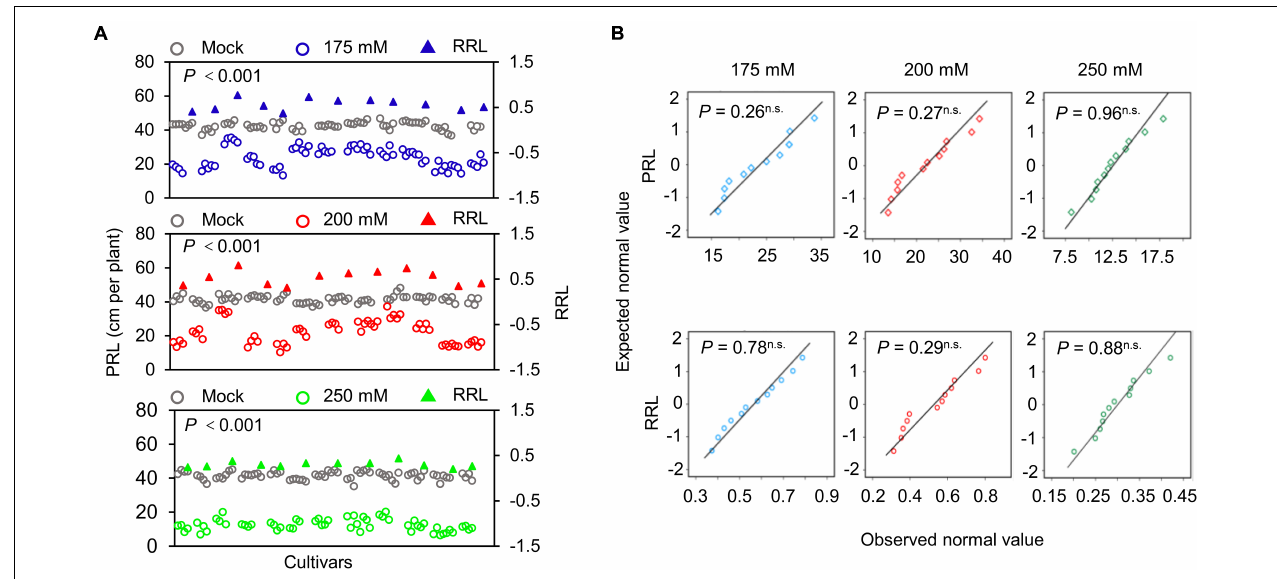
FIGURE 5 | Determination of primary root length. (A) Scatter distribution map of PRL (circles) and relative primary root length (RRL, triangles) of soybean seedlings. Gray, blue, red, and green represent the soybean seedlings grown under mock treatment or NaCl treatment of 175, 200, or 250 mM, respectively. Each circle represents the PRL of an individual seedling. Each triangle represents the value of the RPL of a soybean cultivar. Data were collected 10 days after planting. A paired Student’s t -test was conducted between mock and NaCl-treated seedlings to test for significance. (B) Quantile-quantile plots of PRL and RRL. The normality of the data was tested using the Shapiro-Wilk test. P , P -value; n.s., not significant. The planting design is shown in Supplementary Figure 1